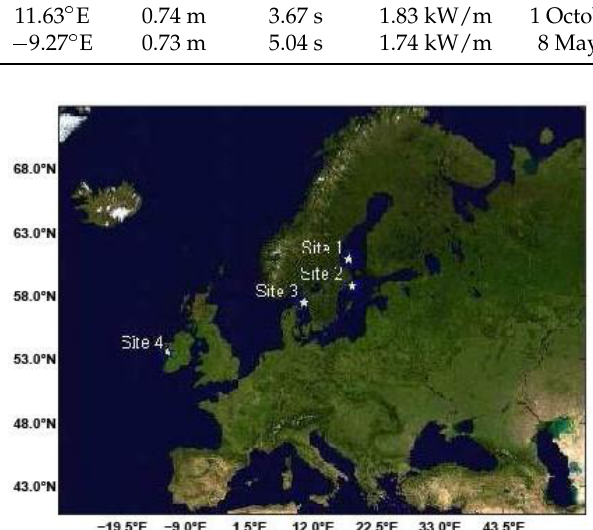
Figure 12. Location of the four chosen sites.